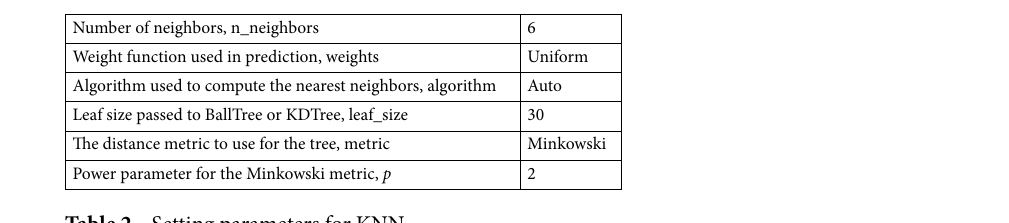
Criteria for measuring the quality of a split, criterion Gini Maximum depth of decision tree 30 Minimum number of samples required to be at a leaf node 1 Minimum number of samples required to split an internal node Number of trees in the forest, n_estimators